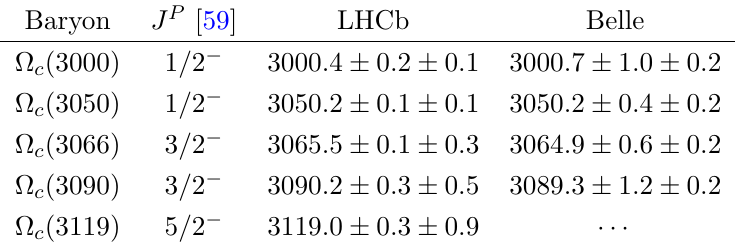
Table 15 . Experimental data from the LHCb [63] and Belle [64] collaborations. (Masses are given in MeV.) All the measurements have the uncertainty +0 : 3 MeV coming from the mass of the ground- (cid:0) 0 : 5 state (cid:4) + -baryon, which is common in both analysis. The spin-parity, J P , assignment assumes that c all the states are orbitally-excited baryons as suggested in